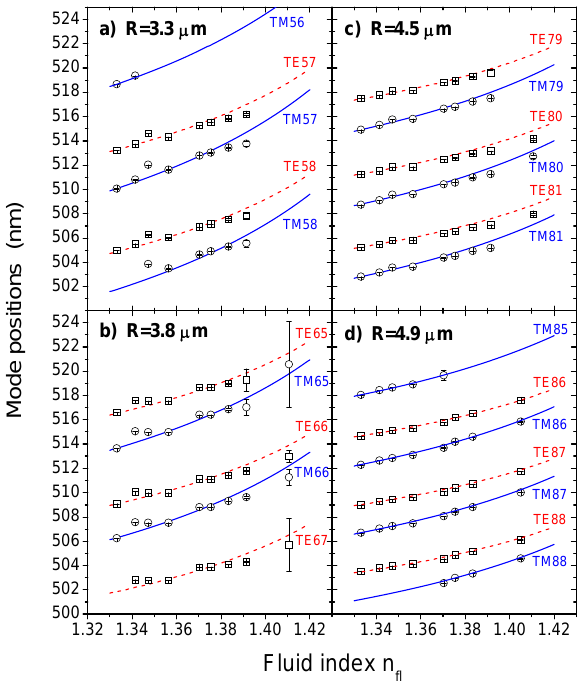
Figure 3. Wavelength positions of the WGMs of the four different beads shown in , of the DI water/glycerol mixture injected Figure 2 in dependence of the fluid index, n fl into the microfluidic flow cell. The solid (TM) and dashed lines (TE) were calculated using the Airy approximations given in Equation 1 and the best-fit parameters for  , n , and s R resulting from an evaluation of the respective spectra obtained in DI water by assuming n = 1.333. The different modes are labeled according to their polarization, TM or TE, and e mode number, 21   . The errors shown are the variances calculated by the least mean square fitting